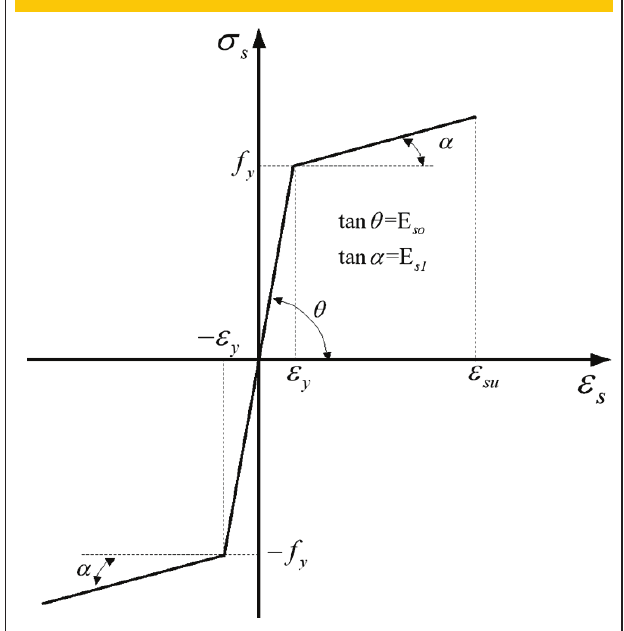
Figure 6 – Bilinear constitutive model for steel